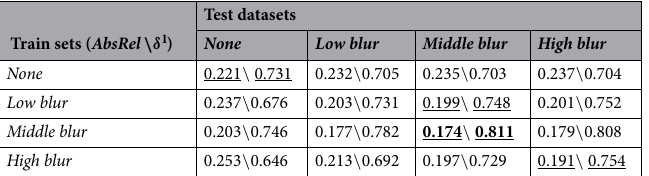
Train sets ( AbsRel \ δ 1 )